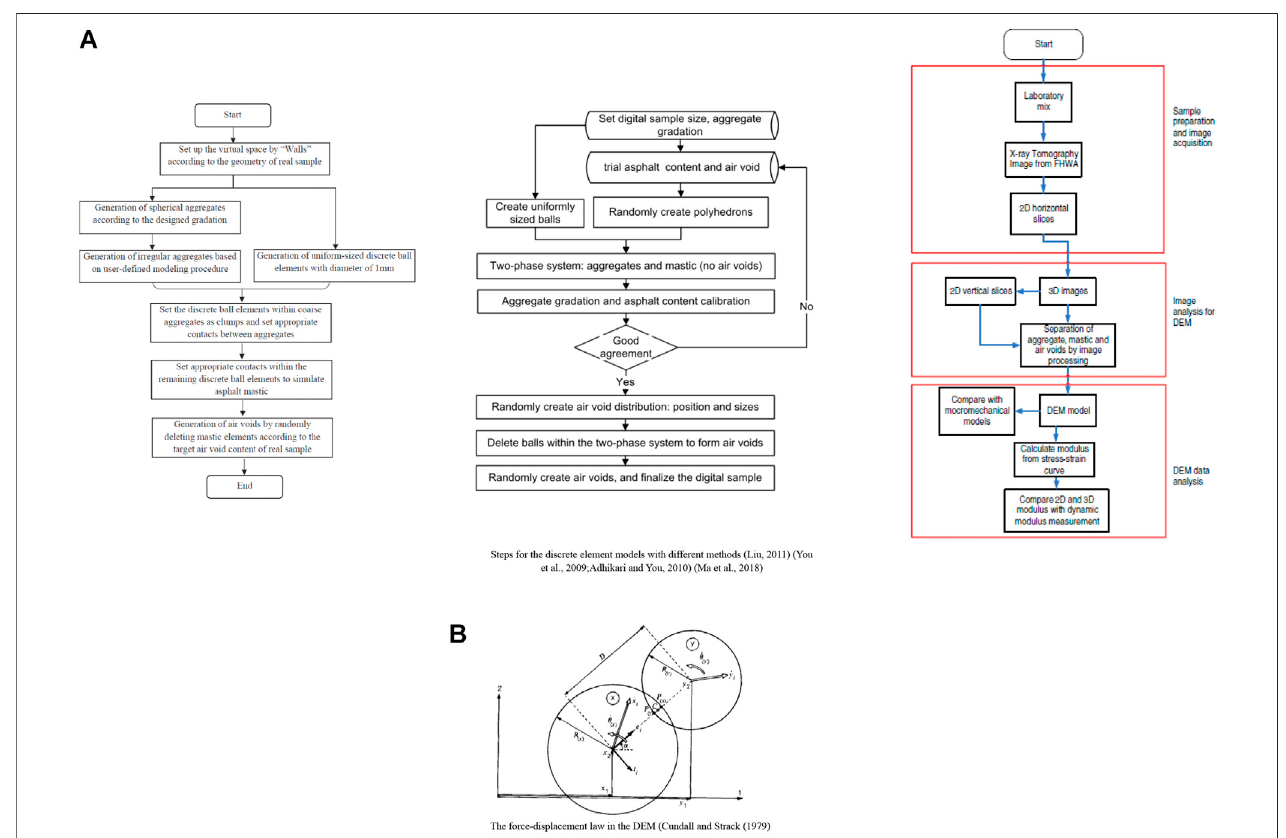
FIGURE 11 | Dem modelling steps and interaction behaviors between balls (Liu, 2011; You et al., 2009; Adhikari and You, 2010; Cundall and Strack,1979; Ding et al., 2019; Ma et al., 2018). (A) Steps for the discrete element models with different methods(Liu, 2011; You et al., 2009; Adhikari and You, 2010; Ma et al., 2018). (B) The force-displacement law in the DEM(Cundall and